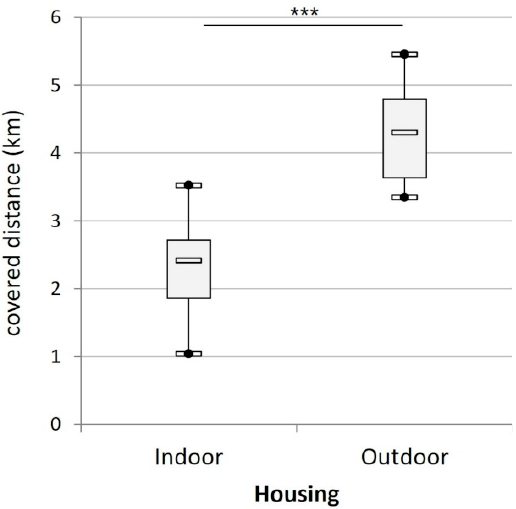
Figure 4. Mean daily distance (km) covered by the cats according to their housing condition (indoors (n = 15) versus outdoors (n = 8)). (***) indicates p < 0.001. The outdoor population tended to move more frequently than the indoor one (108.8 ± 1.5 10-min periods per day versus 101.0 ± 0.6, respectively, t 21 = − 1.906, p = 0.070).